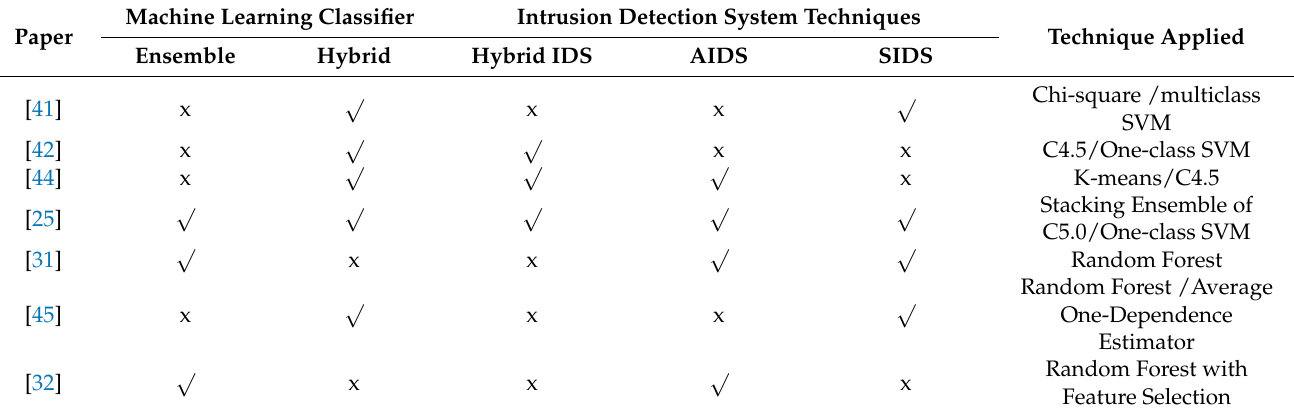
Table 2. Detection model: hybrid machine learning